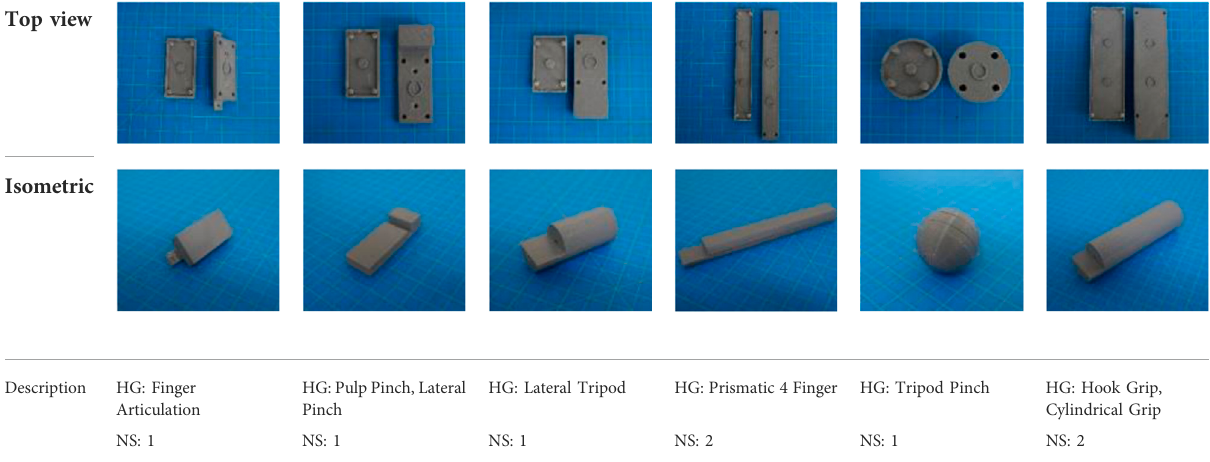
TABLE3ThedifferentmanipulandausedtocharacterizetheforceoutputoftheBEARPAWforindividual fi ngerarticulationandcommongeneralized hand grasp con fi gurations. The hand grasp (HG) used and the number of sensors (NS) for each manipulandum are noted and each square on the blue background is 1 cm by 1